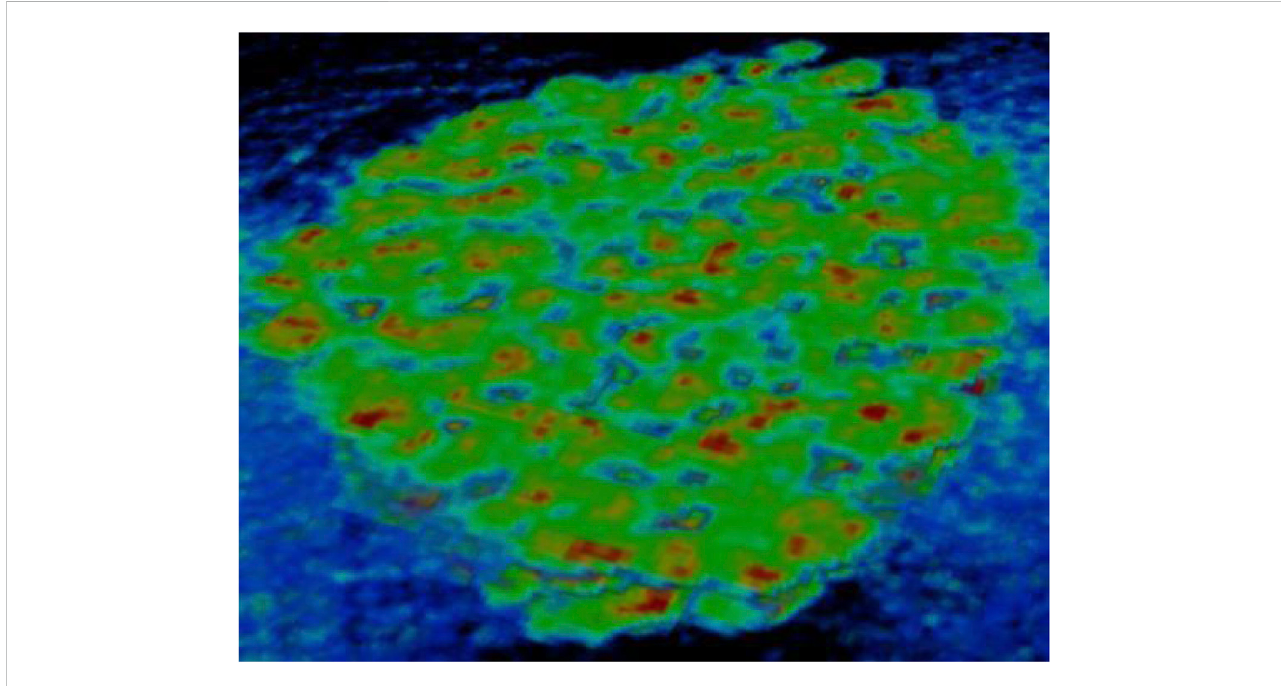
FIGURE 22 Three-dimensional display of the reconstruction results of